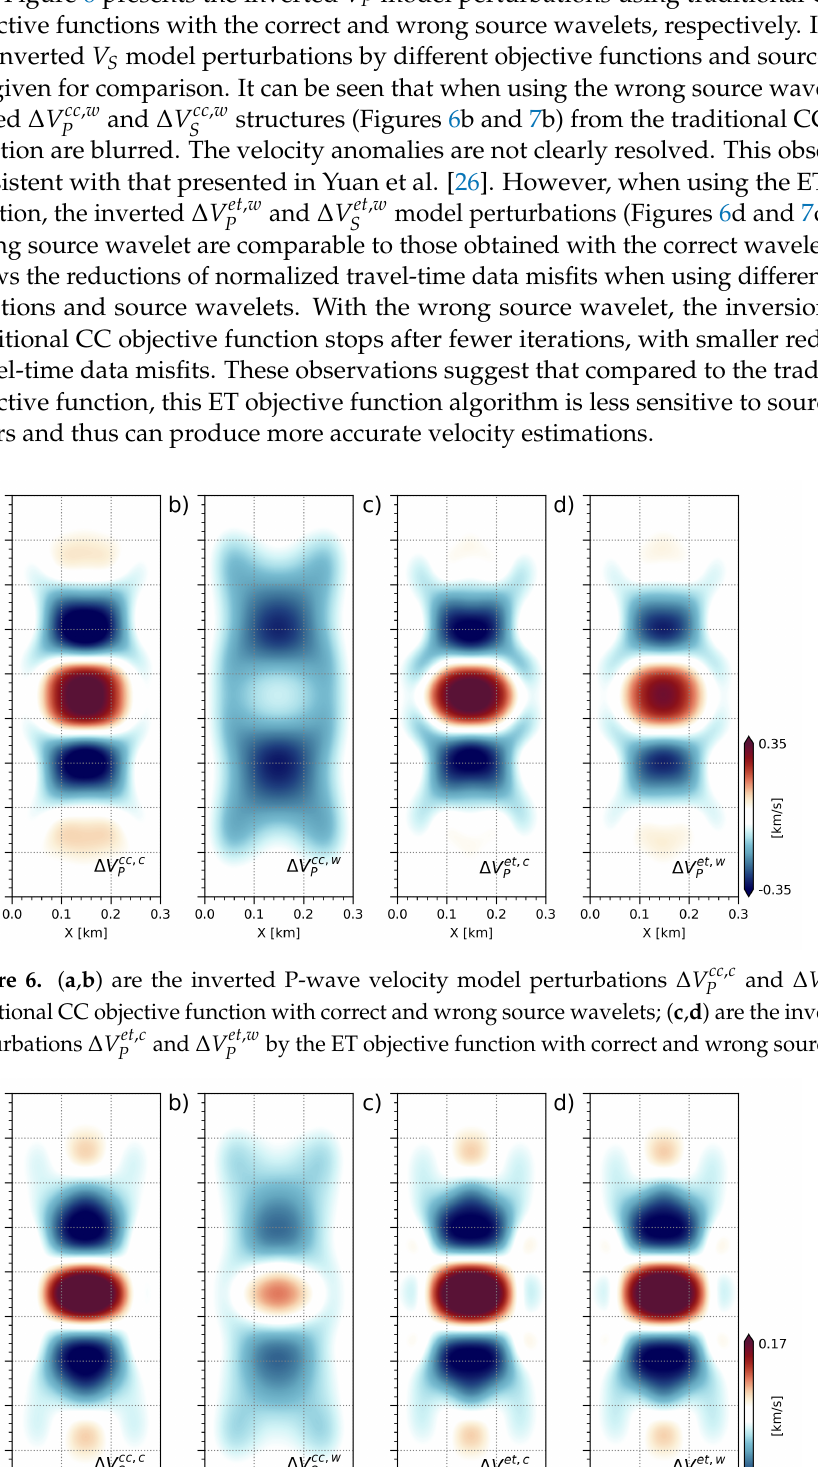
and ∆ V cc , w by the S S